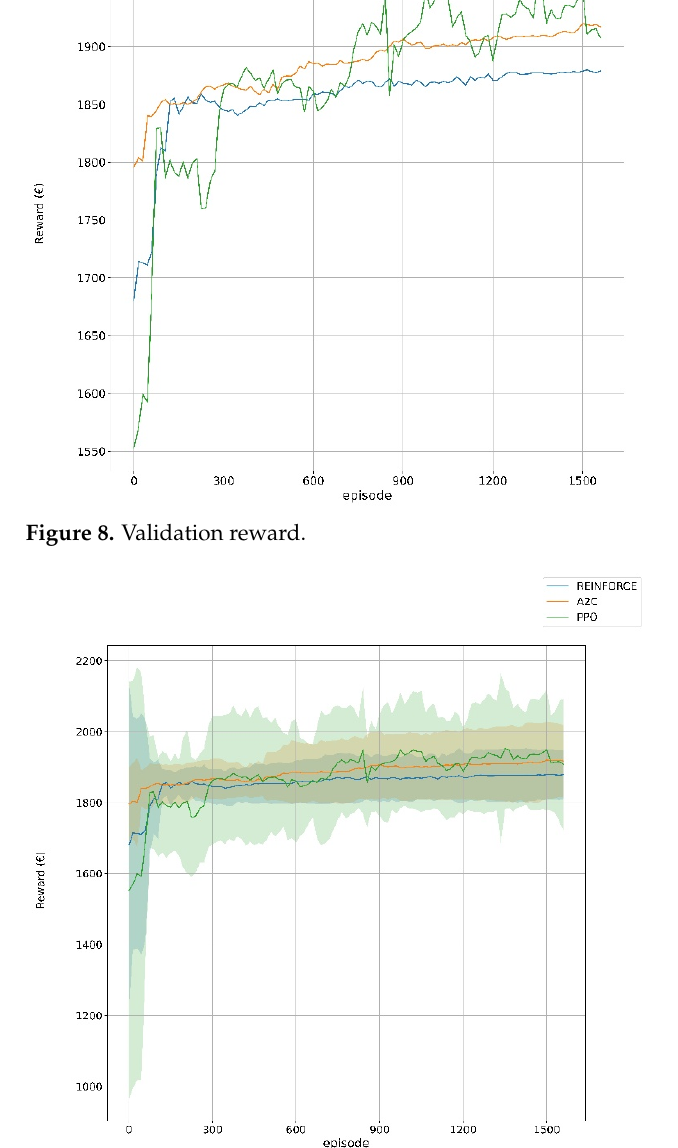
Figure 9. Validation reward with standard deviation.